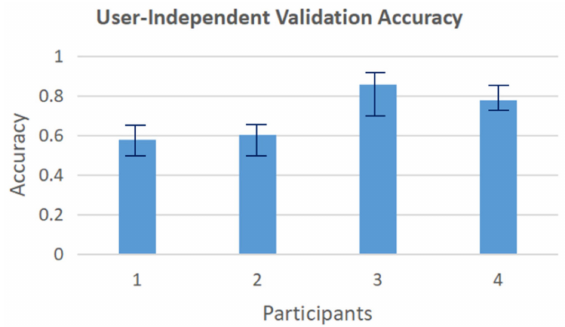
Figure 10. User-independent validation accuracy of the model for raw